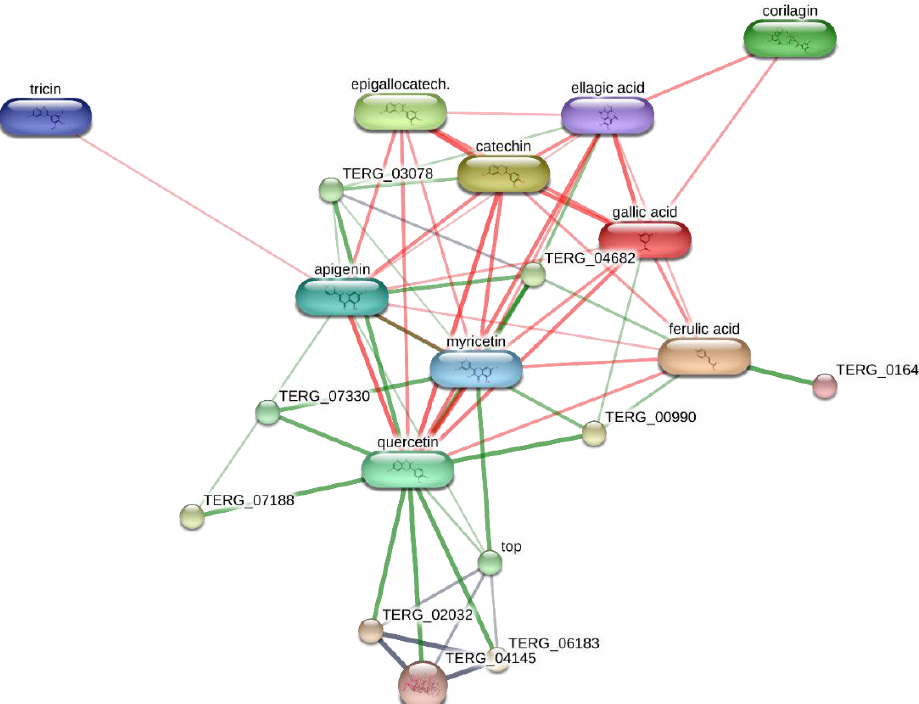
Figure 3. Components–targets analysis built through the bioinformatics STITCH platform that predicted putative interactions between extracts’ phytochemicals (quercetin, gallic acid, ellagic acid, catechin, apigenin, corilagin, epigallocatechin, myricetin, ferulic acid, tricin) and different dermatophytes ( T. rubrum ) enzymes.